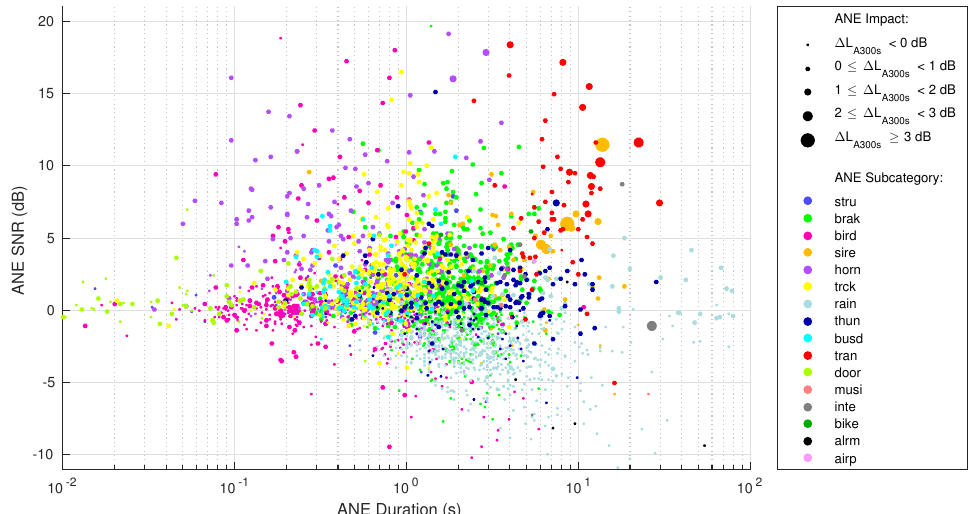
Figure 8. Scatterplot of all ANE parameters separated in subcategories (recorded and labeled in the 2nd and the 5th of November